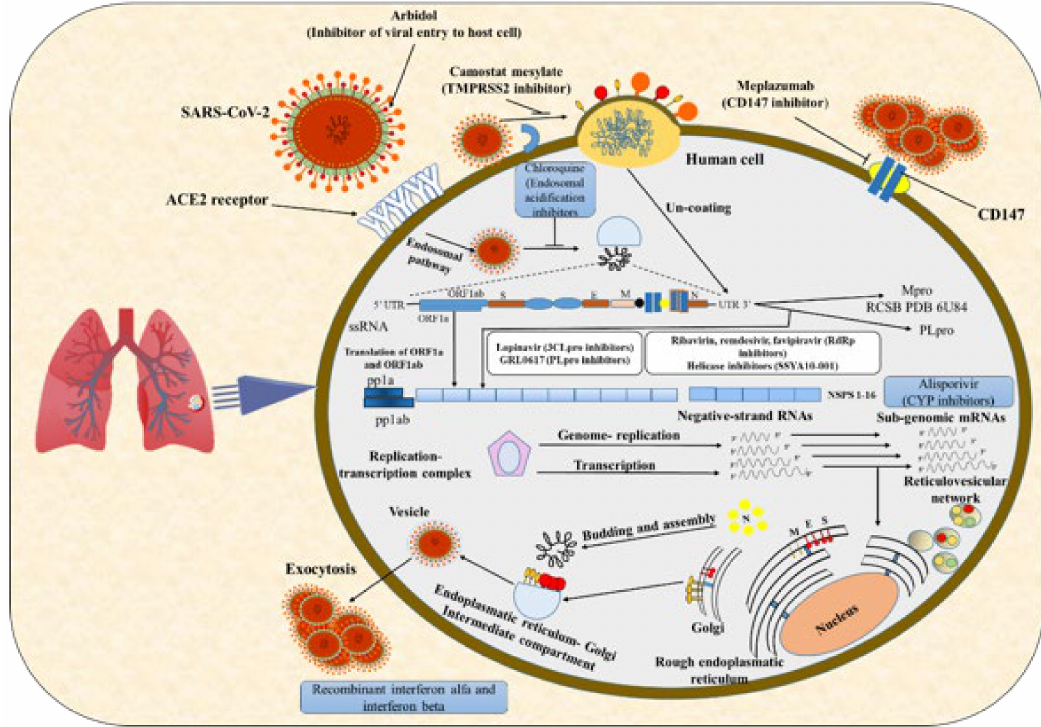
Figure 2. The replication cycle of SARS-CoV-2 and its inhibitors. The binding of the spike (S) protein to the host cell receptor initiates SARS-CoV-2 infection. SARS-CoV-2 has so far been linked to two cellular receptors: angiotensin-converting enzyme 2 (ACE2) and CD147. The cleavage of the S protein by the cell surface-associated enzyme occurs after receptor